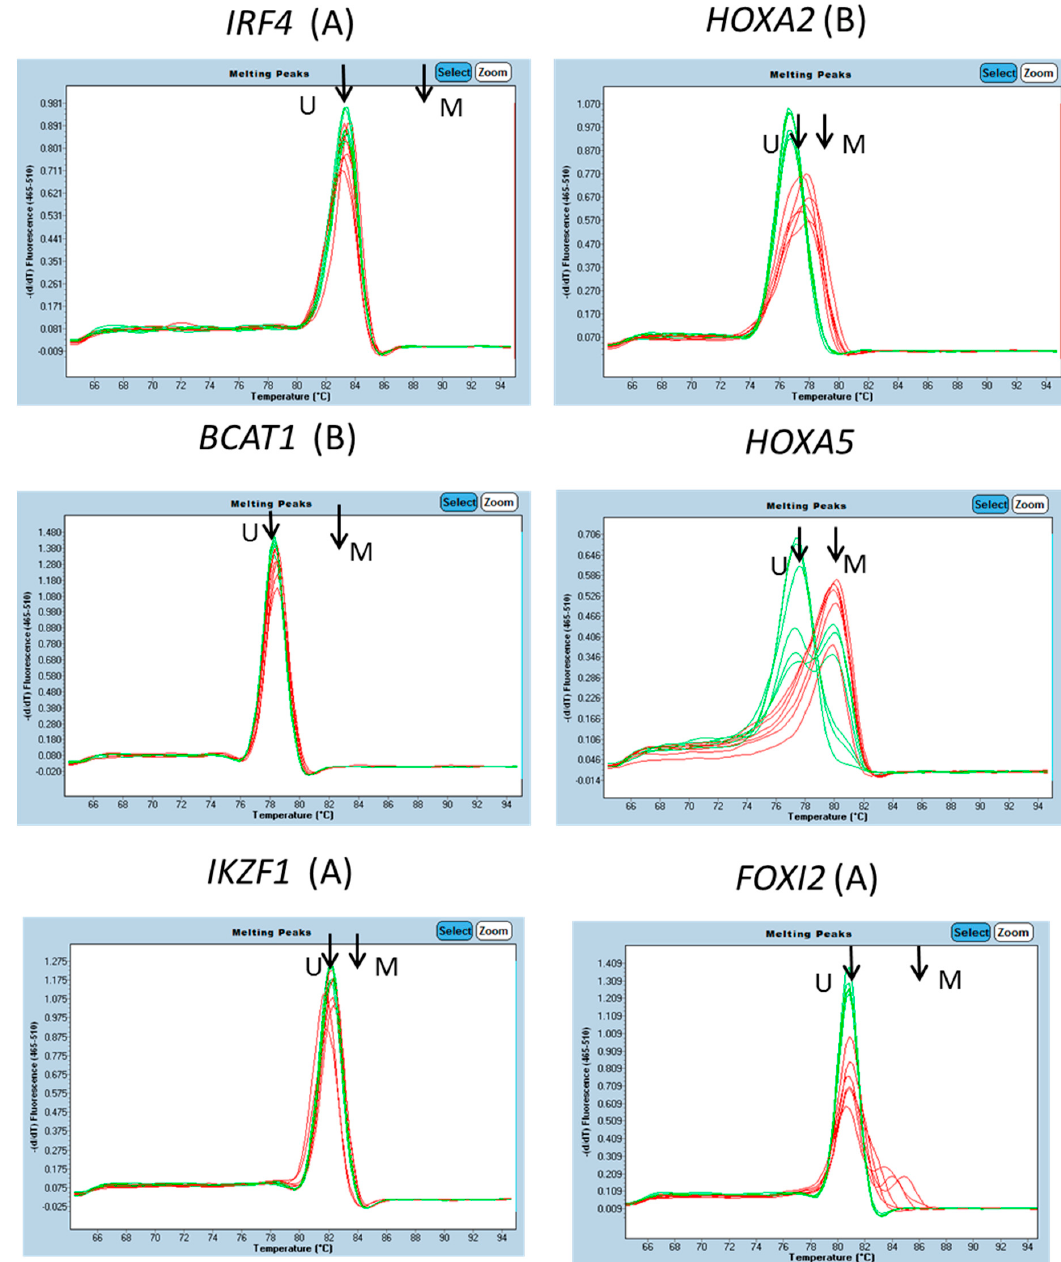
Figure 2. Amplicon melt curve analysis. For each amplicon, melt curves of triplicate amplifications of pooled male and female DNA (six samples in all) from the DNA fraction captured by MBD-Cap (red traces) and DNA not captured (green traces) are shown. Arrows indicated the melt peak positions for control unmethylated (U) and fully methylated (M)